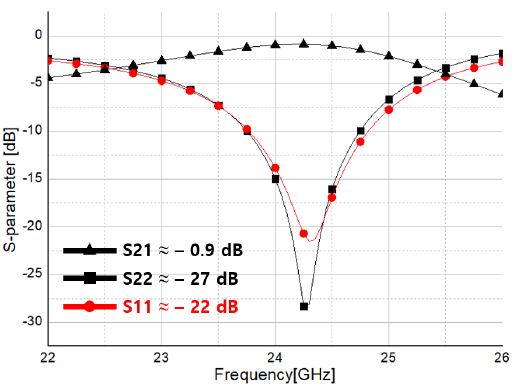
Figure 29. RF Front-End S-parameter simulation result including stub